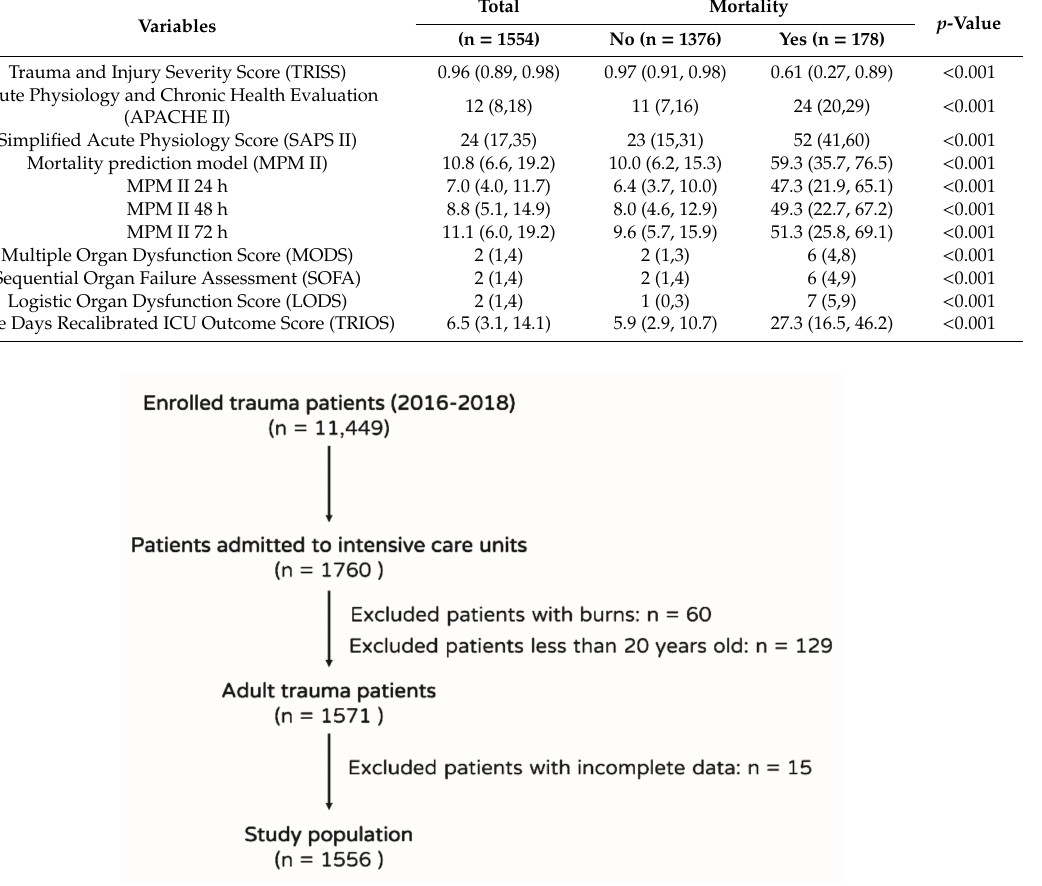
Figure 1. Flow chart showing the selection of trauma patients in the intensive care unit (ICU) for the study